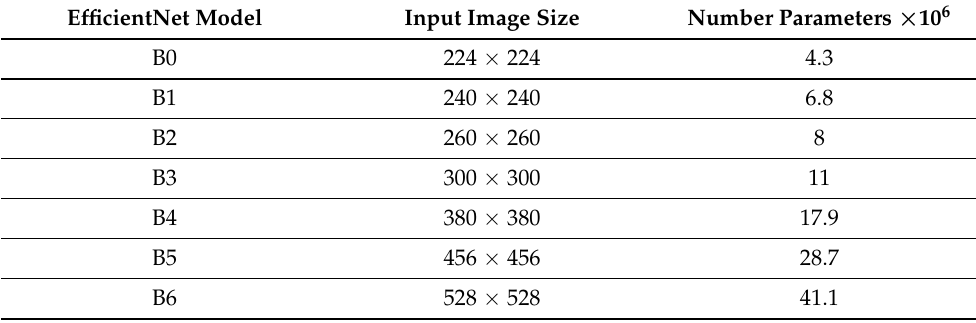
Table 2. Number of parameters in each EfficientNet and its corresponding input image size.